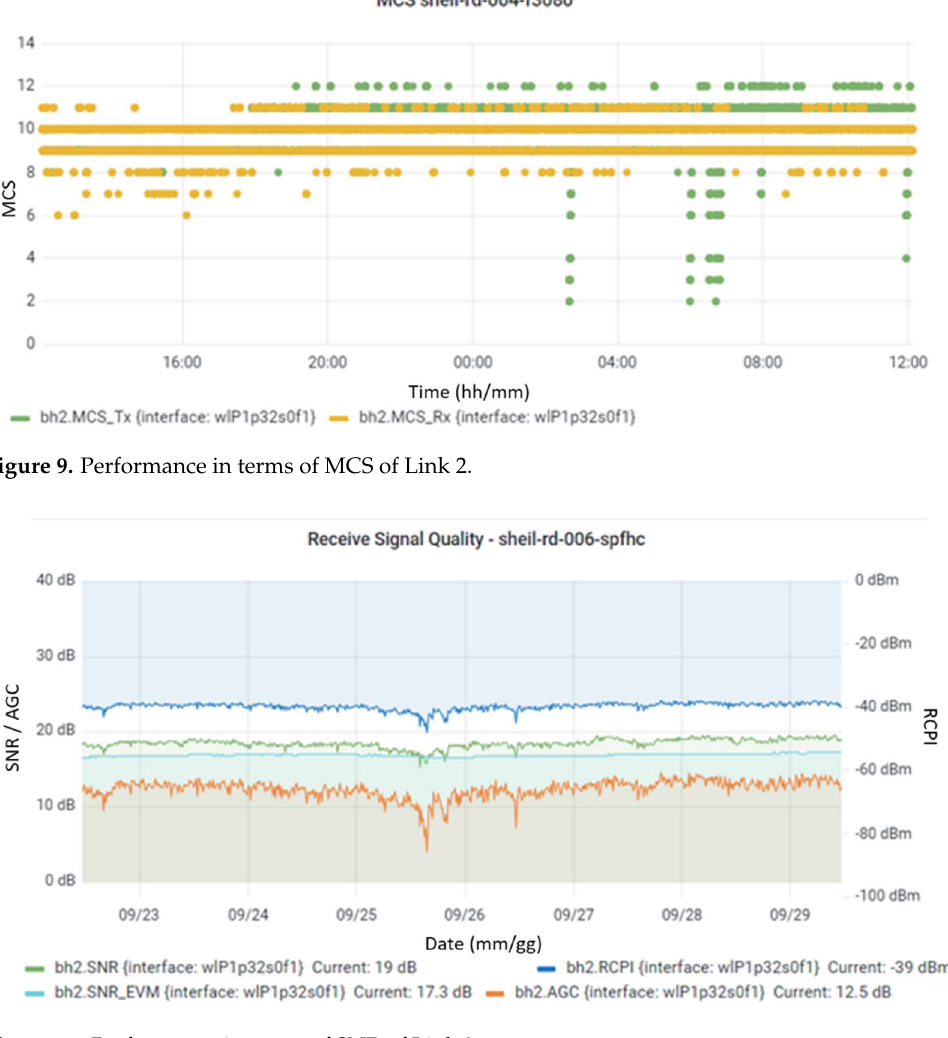
Figure 10. Performance in terms of SNR of Link 3.